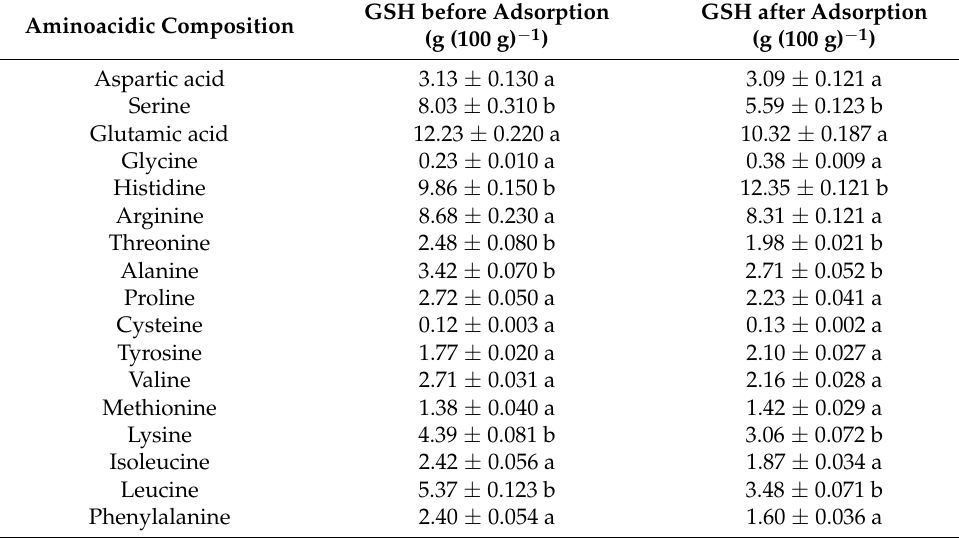
Table 5. Aminoacidic composition (g (100 g) − 1 ) of the GSH sample from batch 2 (20.97 mg L − 1 ) before and after the cadmium adsorption in fixed-bed columns connected in series . The experimental conditions were a pH of 6.2, a flow rate of 140 mL min − 1 , and a temperature of 55 ◦ C. The results are expressed as the dry weight and are the average of three repetitions.